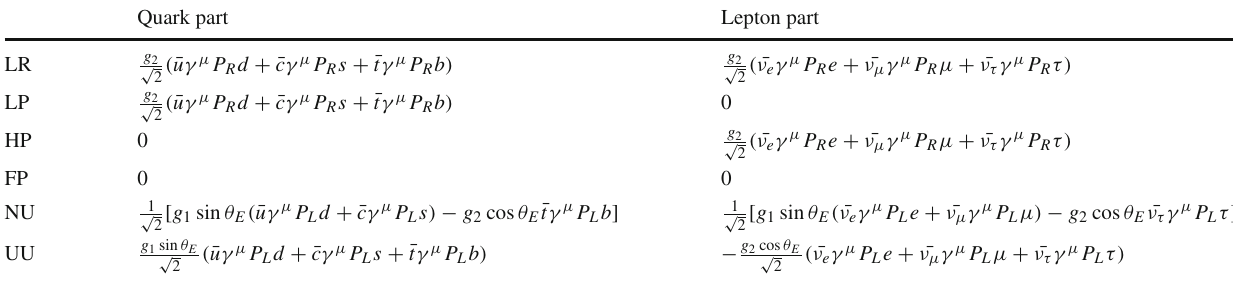
Table 1 The charged current K + μ for the LR, LP, HP, FP, NU and UU models. For the NU and UU models, the mixing angle of the extended gauge group θ E is defined as tan θ E = g 1 / g 2 Quark part Lepton